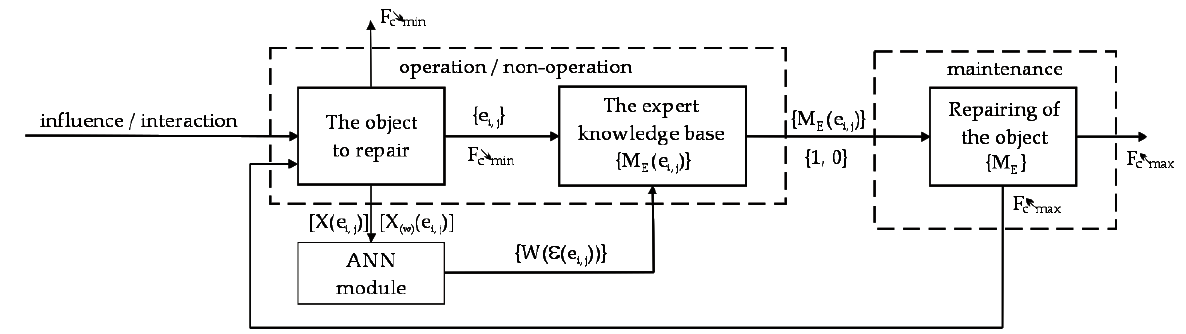
Figure 1. Diagram of operation process for technical object utilizing the artificial neural network.